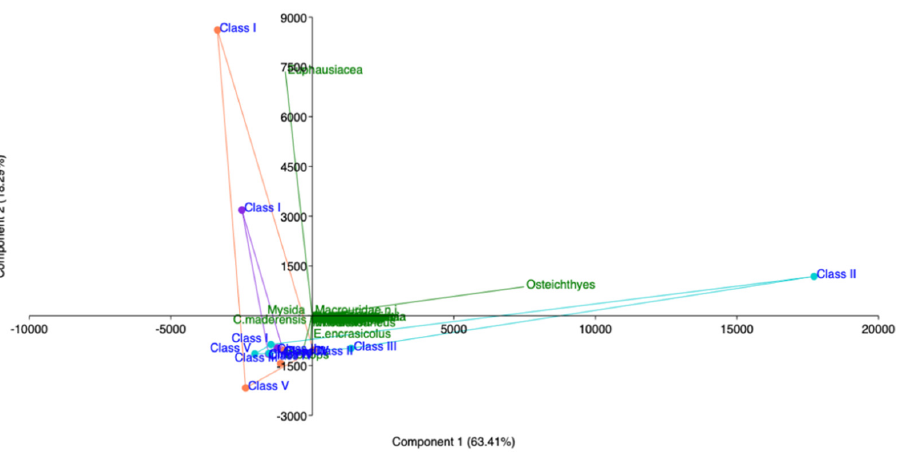
Figure 12. Principal component analysis (PCA) of hake diet in southern and central Tyrrhenian Sea